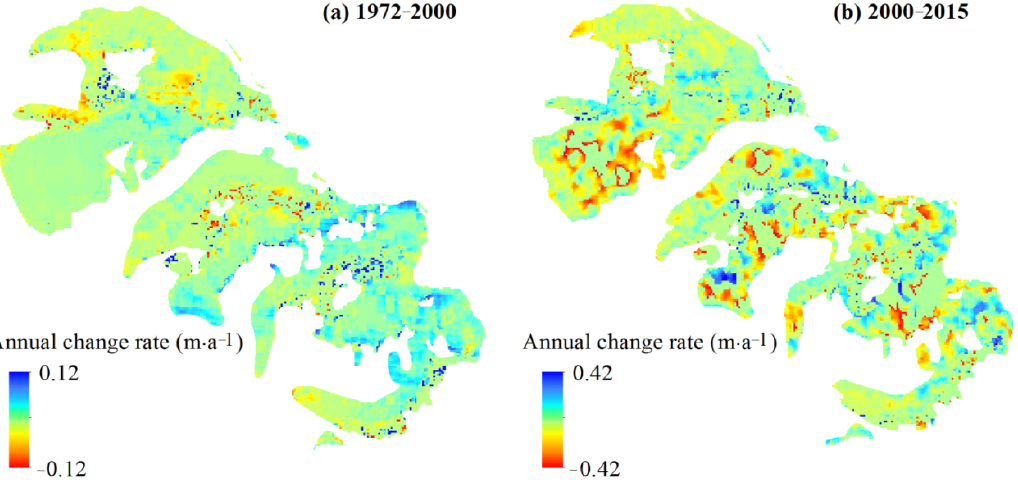
Figure 3. Surface elevation changes of the glaciers in the Yushugou Basin from 1972 to 2000 and 2000 to 2015.